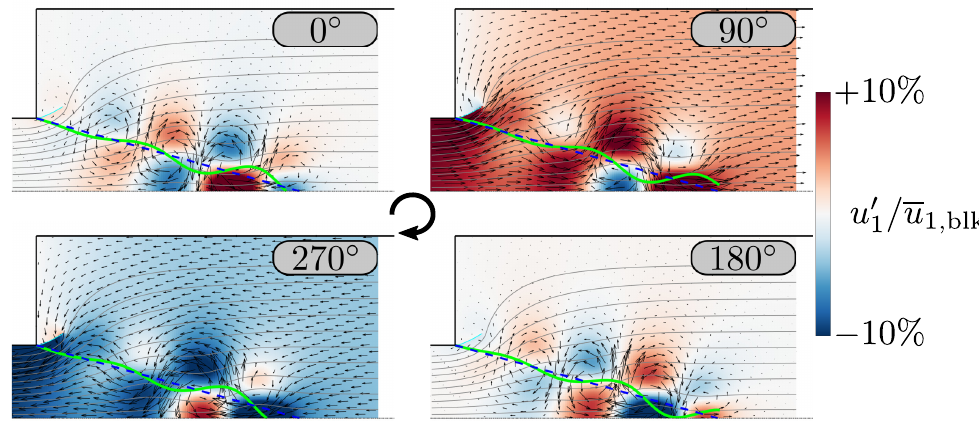
Figure 13. Predictions obtained with the BD model of a flame with confinement ratio C r = 0.4 forced harmonically at 120 Hz and an amplitude of 10% u blk . Color raster: axial velocity u (cid:48) front position ( ); perturbed flame ( ). Minimum vortex kernel radius r 0, ω ,min = 4.25 l M .